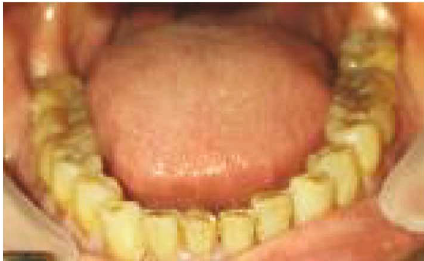
Figure 2: Mandibular teeth showed generalized physiological attrition.